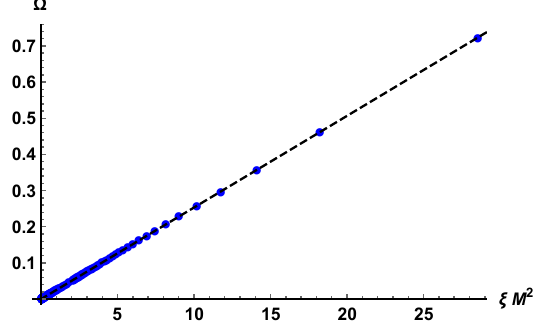
Figure 19 . A cartoon of the transverse pseudo-phonons dynamics in liquids using eq. (5.11). The two lines are constructed by mimicking the increasing of the EXB parameter (cid:11) . More speci(cid:12)cally, from blue to green line, both the damping (cid:0), the pinning frequency ! 0 and the emergent speed v are increased. The behaviour is very similar to what observed in (cid:12)gure 18 (see blue and green lines). This suggest that the emergent speed v grows with the EXB scale.